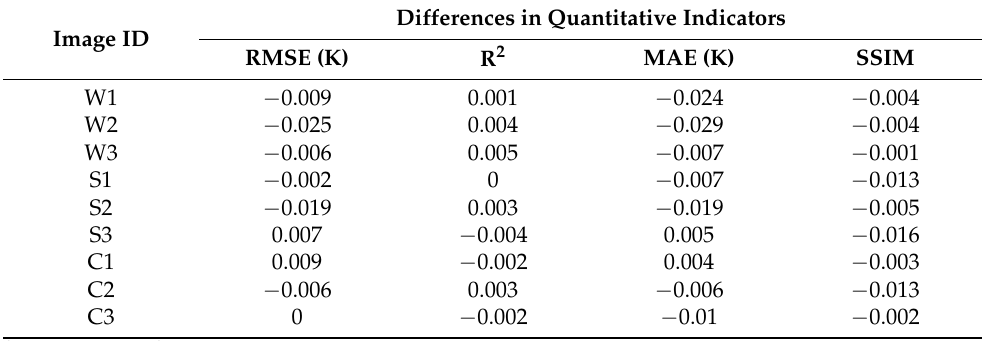
Table 5. Differences in quantitative indicators between SRFD and SRFD-RK downscaling results.